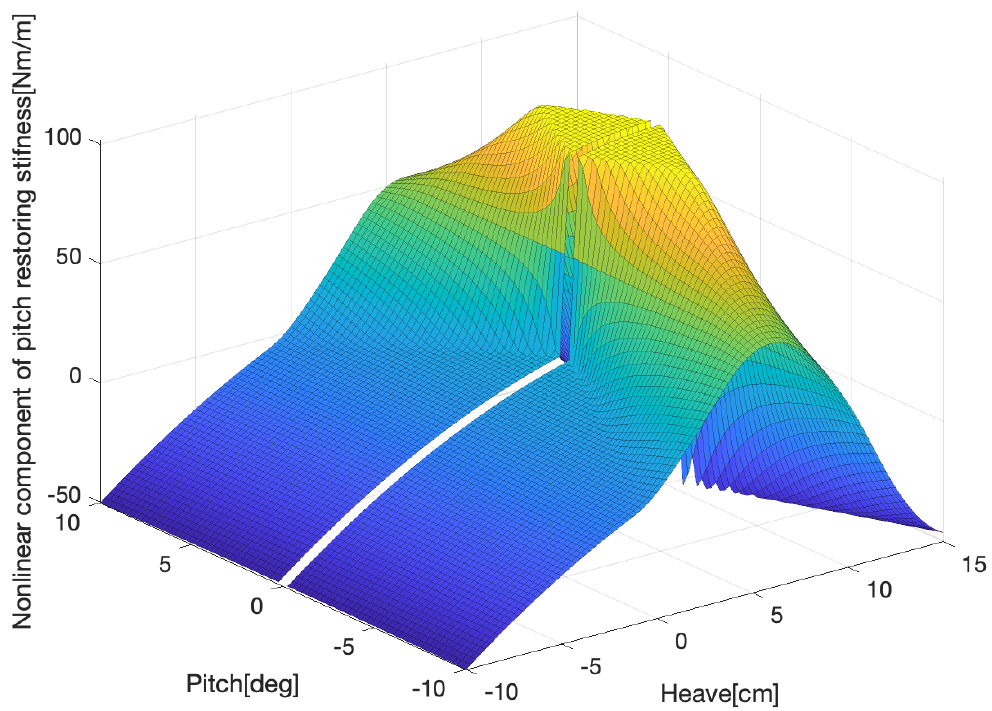
Figure 24. Nonlinear component of the restoring stiffness of